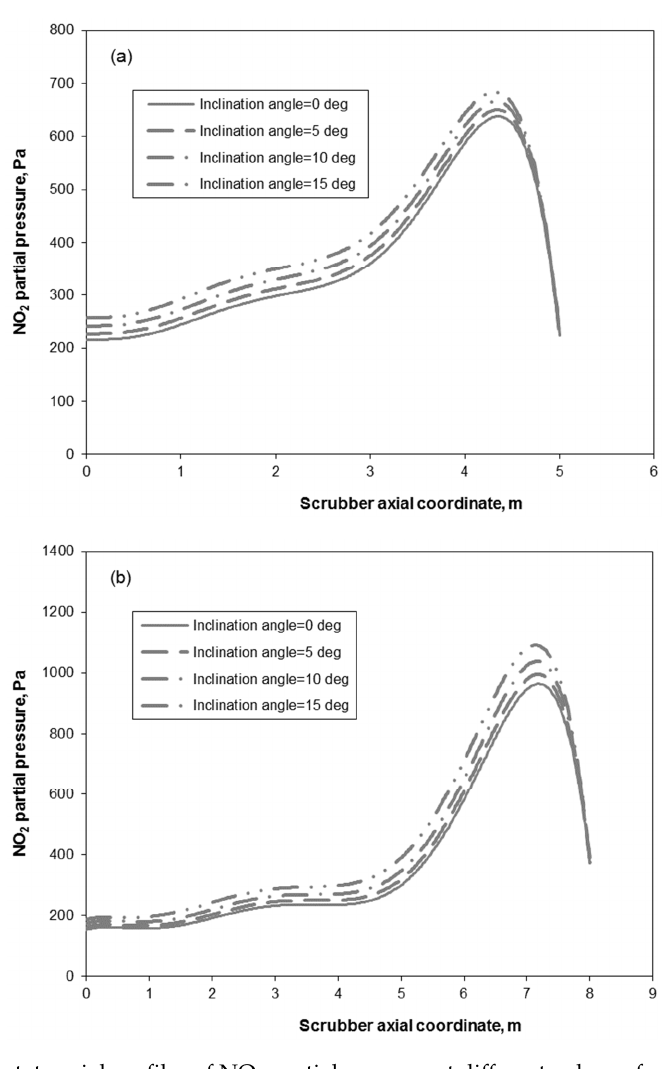
Figure 9. Steady-state axial profiles of NO 2 partial pressure at different values of seawater scrubber inclination angle (Packed-bed column with Raschig super-Rings): ( a ) H = 5 m; P = 1.5 MPa; ( b ) H = 8 m; P = 2.5 MPa.